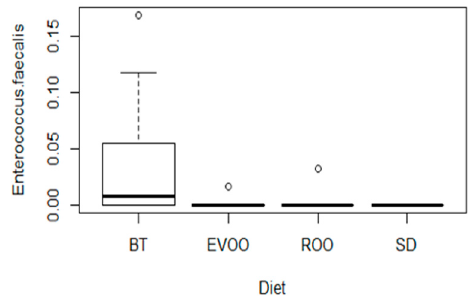
Figure 2. Box-plot representation of the percentage distribution of E. faecalis metagenomic sequences among faecal samples from mice fed a diet enriched with butter (BT; n = 9), virgin olive oil (EVOO; n = 9), refined olive oil (ROO; n = 9) or standard chow (SD; n = 8) ( p = 0.014).